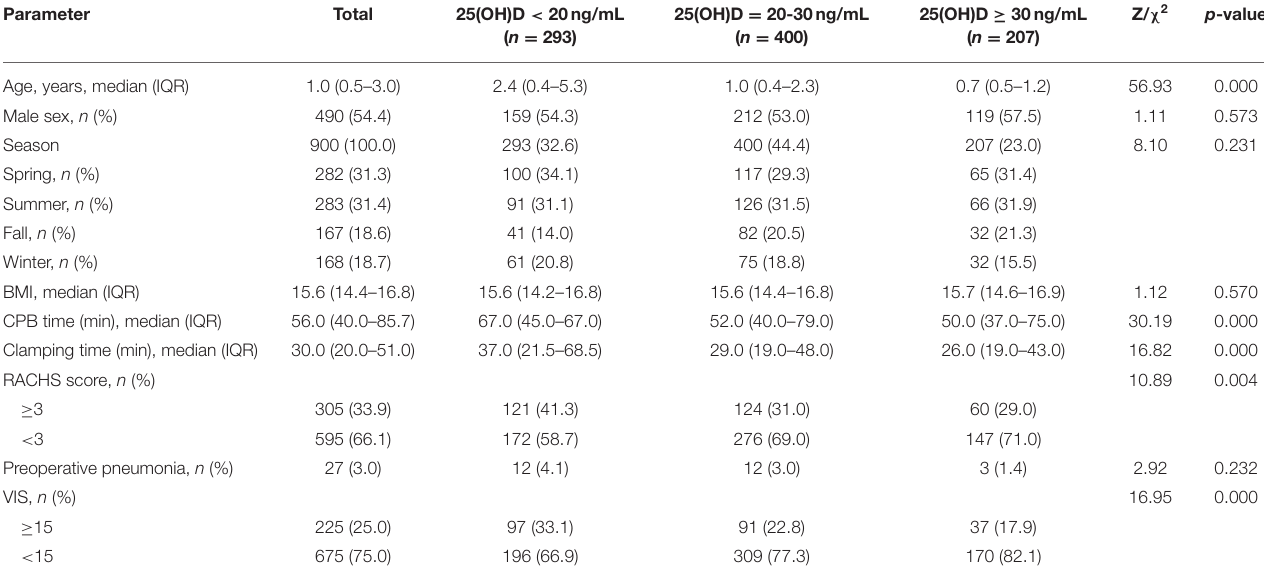
TABLE 1 | Demographic and clinical characteristics of the study participants according to preoperative vitamin D status. Parameter